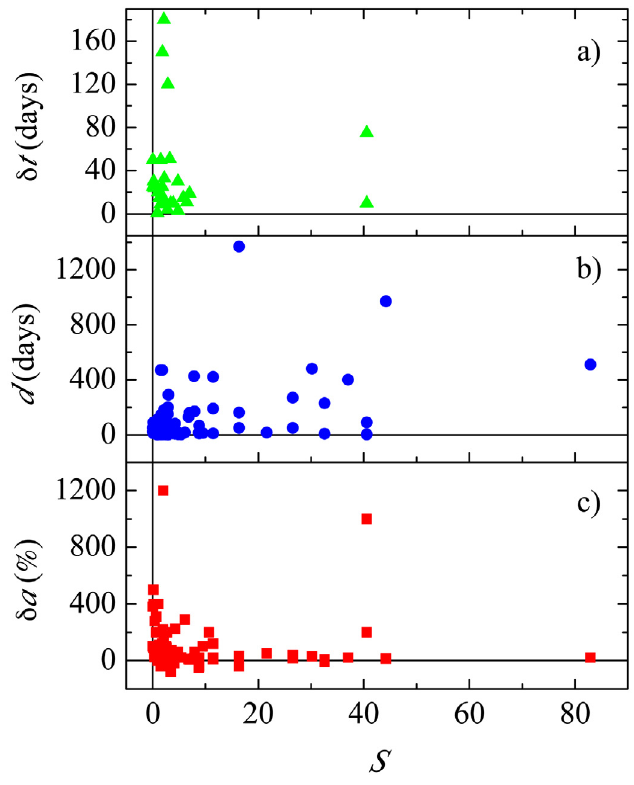
Figure 2. The three parameters of interest presented as functions of S (de- fined in Equation 1). (a) The time interval between the beginning of the radon measurement anomalies and the occurrences of the earthquakes, d t (days). (b) The duration of the anomalies, d (days). (c) The relative ampli- tudes of the anomalies, d a (%). The data shown were extracted from Toutain and Baubron [1999].